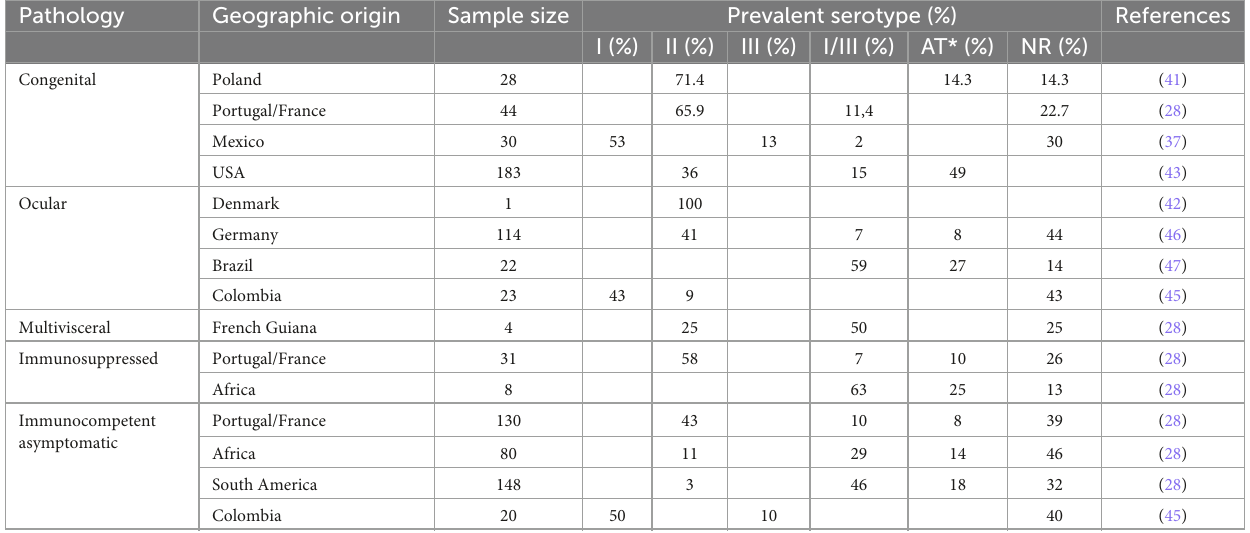
TABLE 5 Toxoplasma gondii serotypes according to pathology and geographic